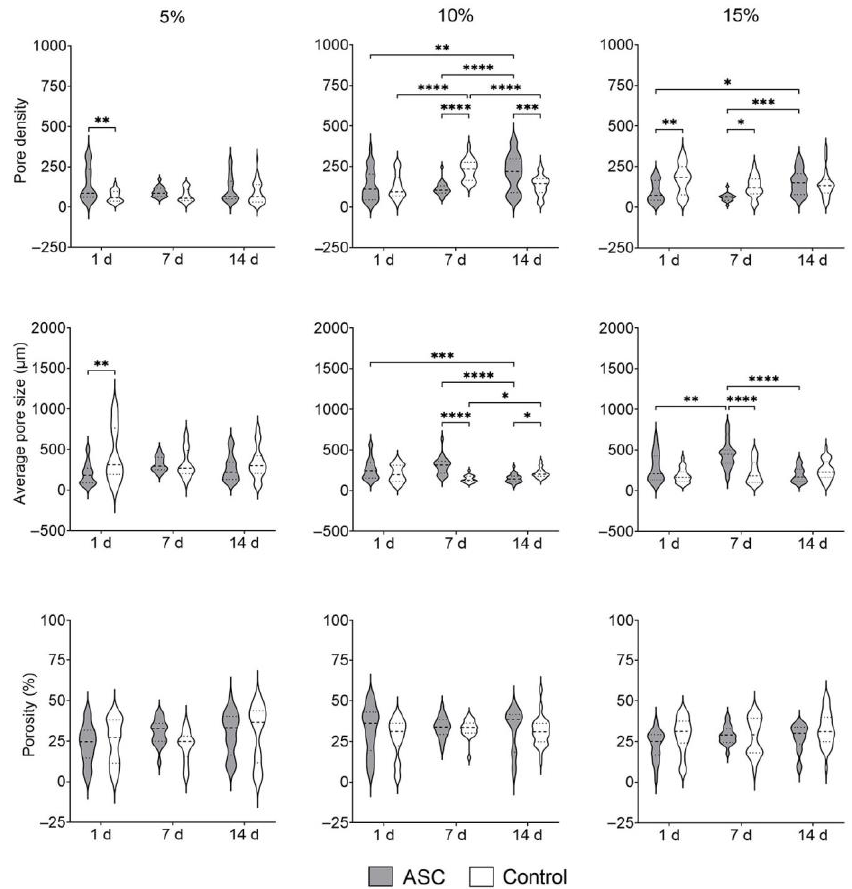
Figure 8. Analysis of GelMA architectural parameters based on SEM imaging of cell-loaded (ASC) and cell-free (Control) hydrogels. The pore density (i.e., number of pores), the average pore size (um), and the porosity % between cell-loaded (ASC) and cell-free (Control) hydrogels. Data derived from three independent samples per timepoint, from a minimum of five random areas per hydrogel. Data are presented as mean with standard deviation. p values are indicated * p < 0.05, ** p < 0.01, *** p < 0.001 and **** p < 0.0001 according to two-way ANOVA and Tukey.